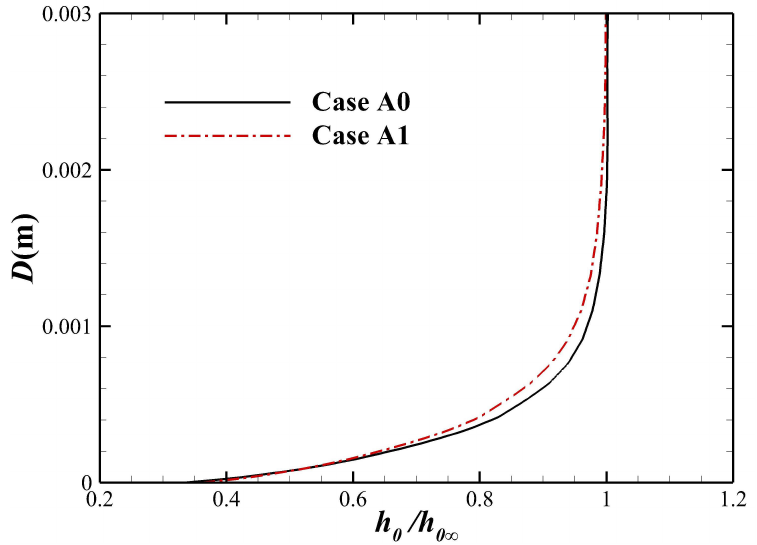
Figure 15. Total enthalpy boundary layer profile at stagnation